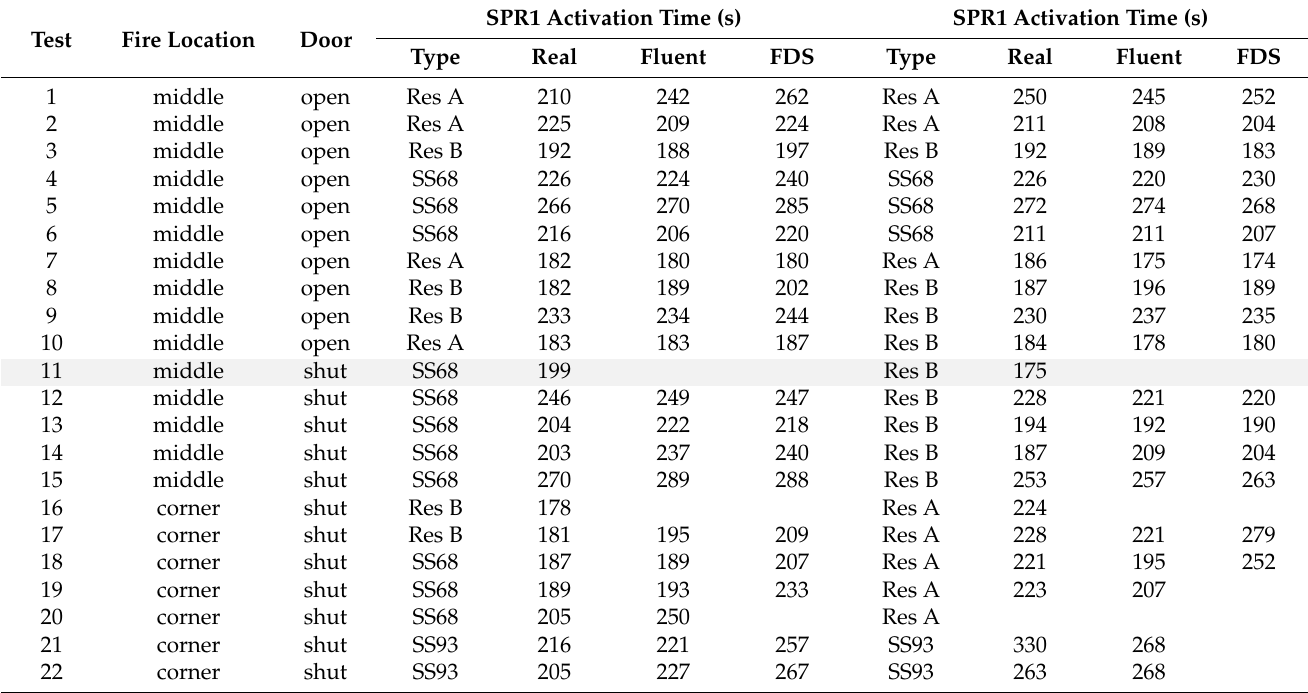
Table 7. Calculated sprinklers activation times ( C =